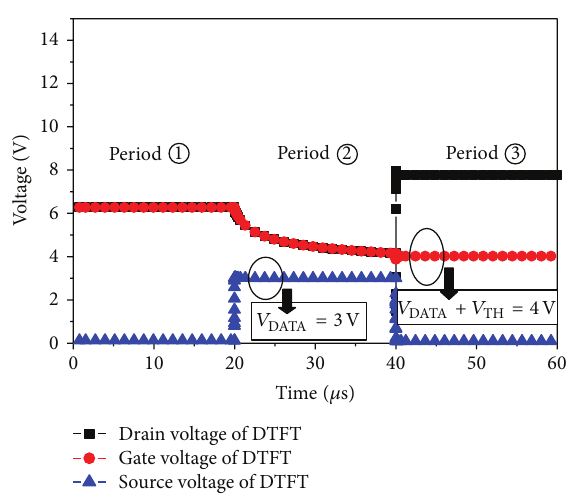
- 𝑉 curves of the poly-Si TFT (DTFT) and (b) the I - V curve of the OLED. DS GS